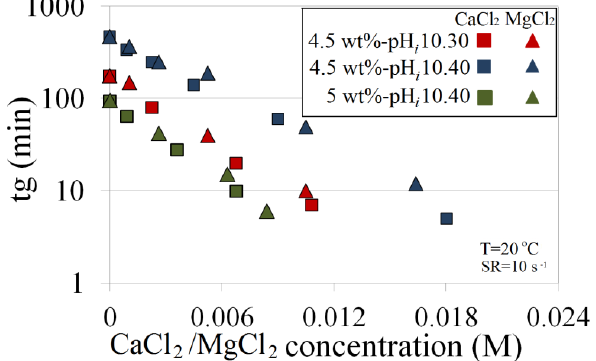
and MgCl concentrations for 4.5 wt% 2 2 s (pH s of ion-free solutions) of 10.30 and 10.40. i i